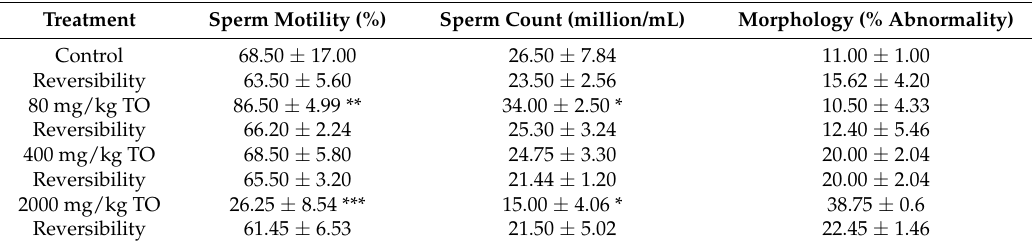
Table 7. Effect of T. occidentalis on sperm motility, count and morphology (% abnormality). Treatment Sperm Motility (%)